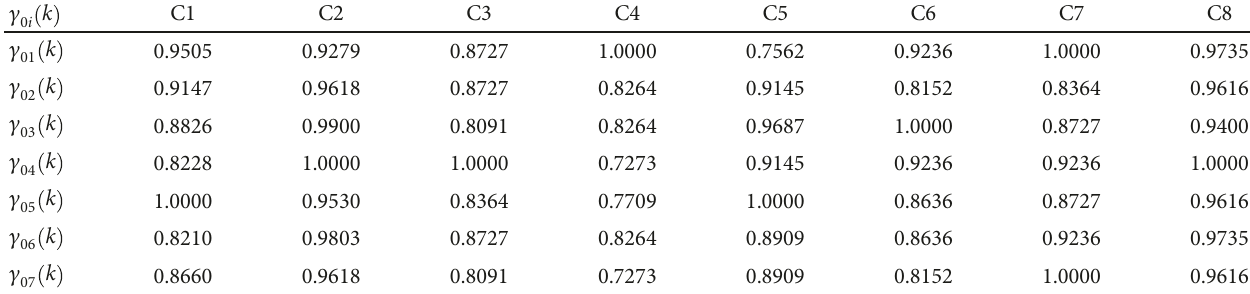
Table 5: Grey incidence coe ffi cient.